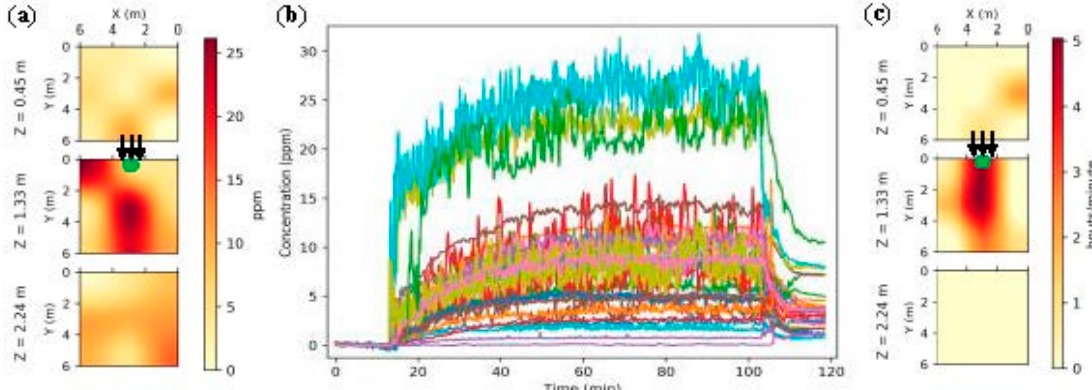
Figure 2. Gas dispersion with artificial airflow. ( a ) Mean gas distribution map at different heights; ( b ) Temporal evolution of the instantaneous concentration (all sensor signals are stacked together); ( c ) Average bout frequency map (bout amplitude threshold [4] is 1 ppm). The gas source (green circle) was located at (3, 0.5, 1.0) m. The airflow (black arrows) was generated by a DC fan located behind the gas source. The maps in ( a , c ) were smoothed using spline